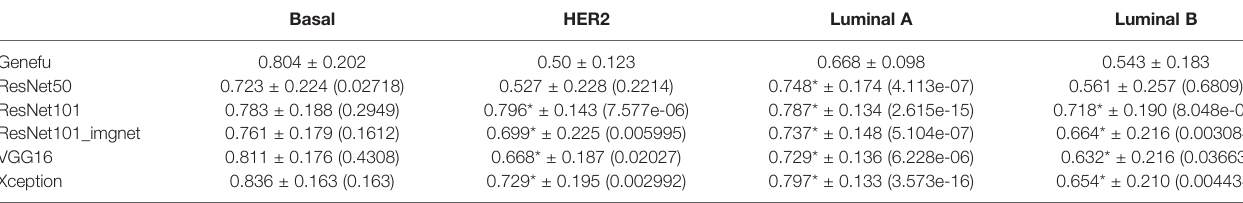
TABLE 5 | Comparison of mean of probability between Genefu method and deep learning models by Wilcoxon signed rank test.